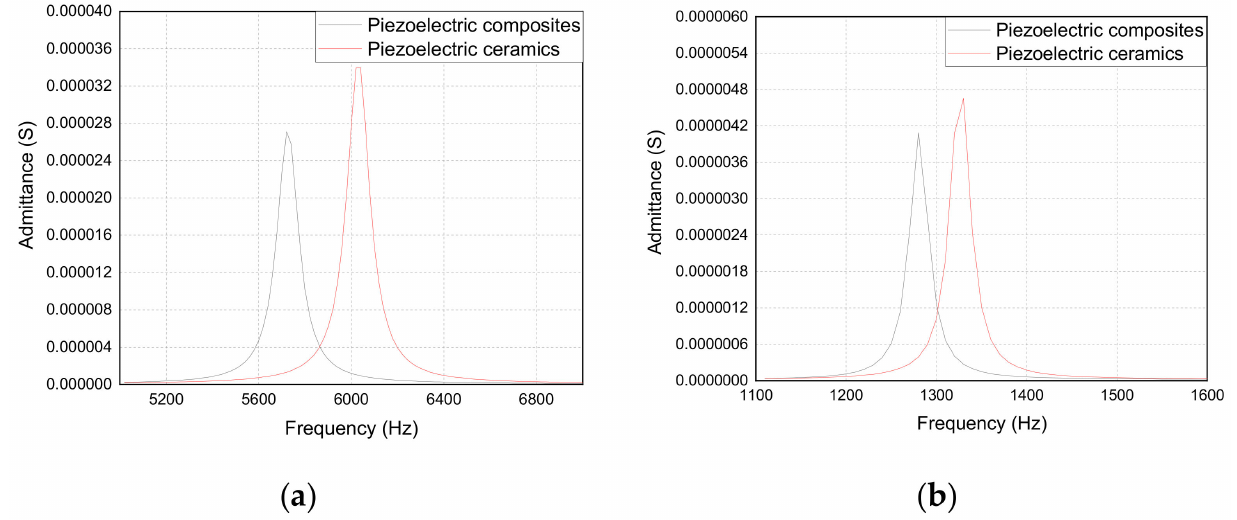
Figure 6. Admittance curve of the trilaminar vibrator: ( a ) free boundary; ( b ) fixed boundary.